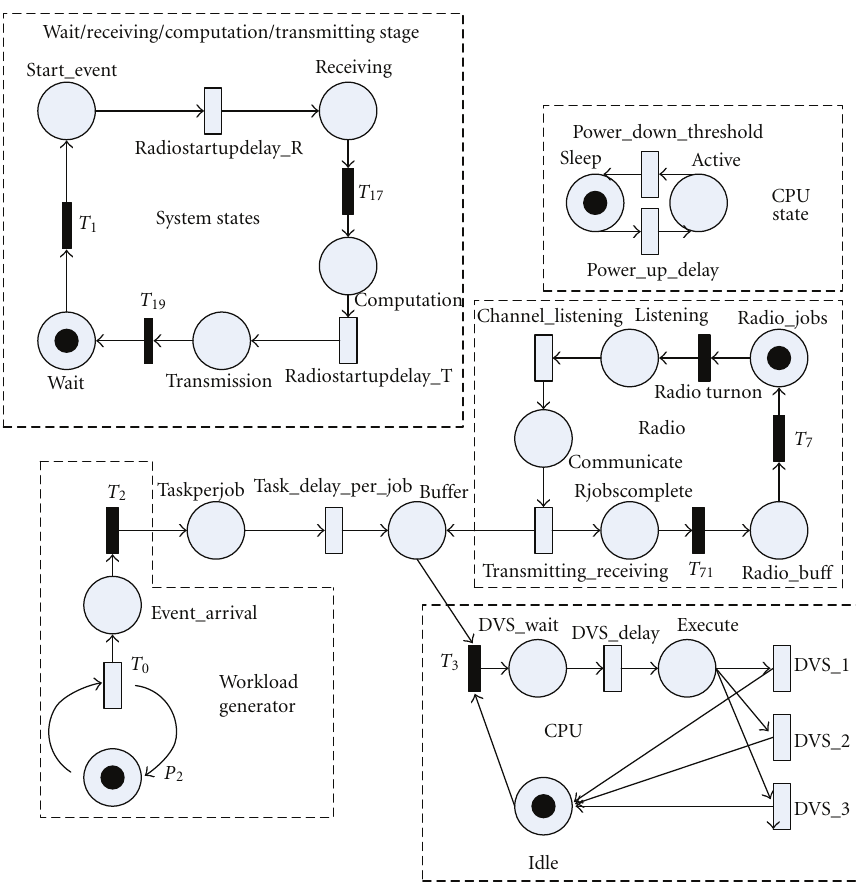
Figure 14: Open system model of node in wireless sensor